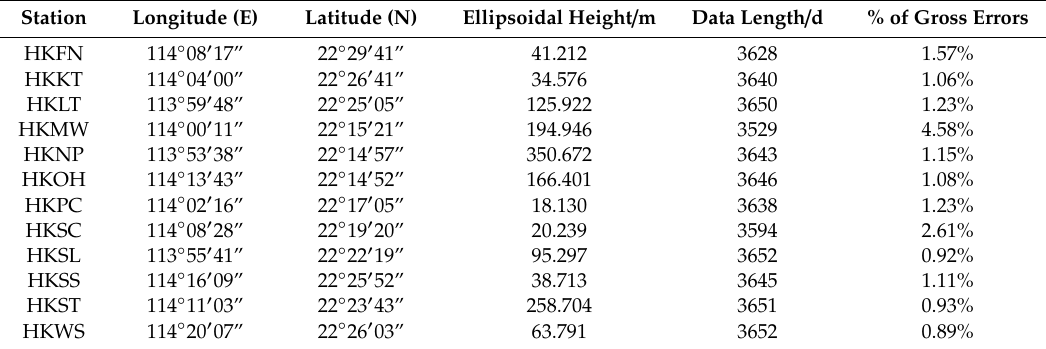
Table 2. WGS84 coordinates and the Gross Error elimination rate for the 12